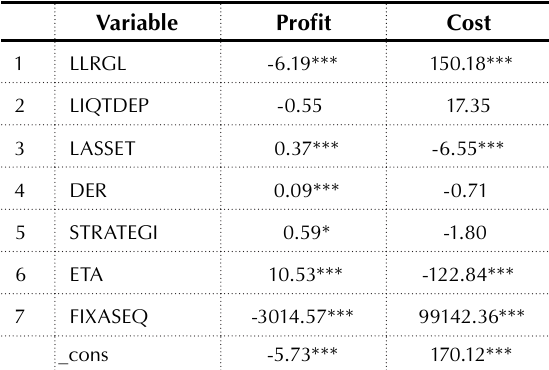
Table 4. The SUR regression